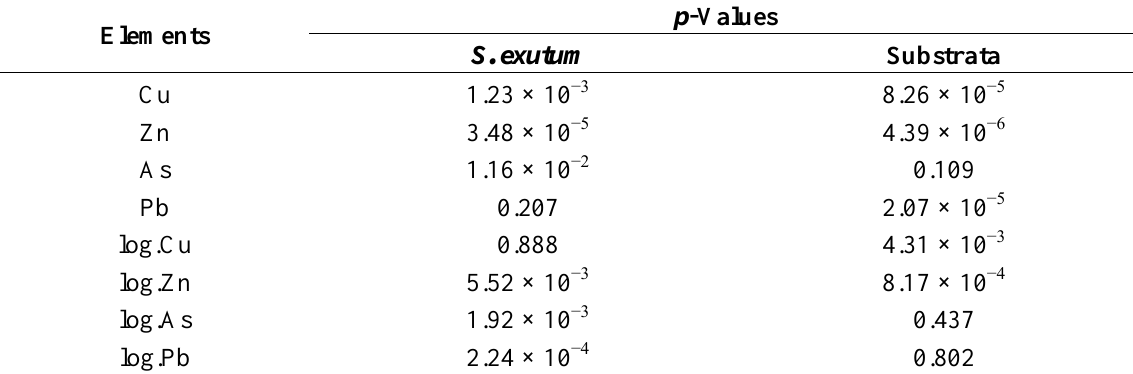
Table 1. p -values of heavy metal concentrations in lichens and the corresponding substrata obtained by Shapiro-Wilk normality